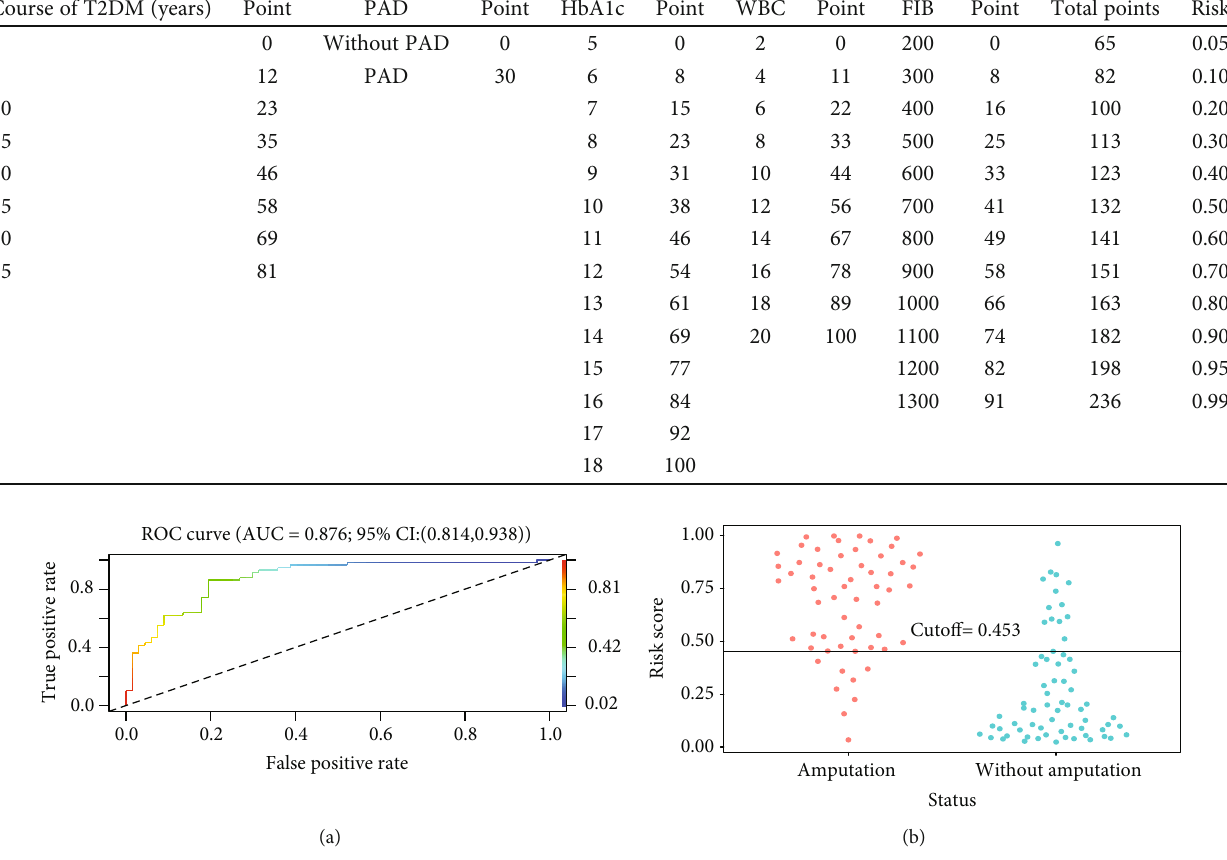
Figure 3: (a) The accuracy of the nomogram for predicting DFA using ROC curve. (b) The use of a cuto ff value of 0.453 of the nomo-score performed well for the di ff erential diagnosis of amputation from without amputation in the patients with diabetic foot ulcers.